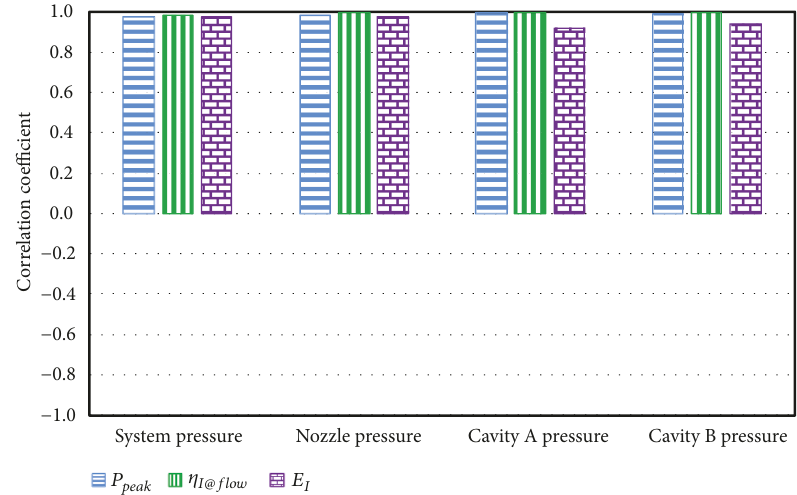
Figure 13: Correlation between pressure-based quality indexes and product weight for various back pressures.